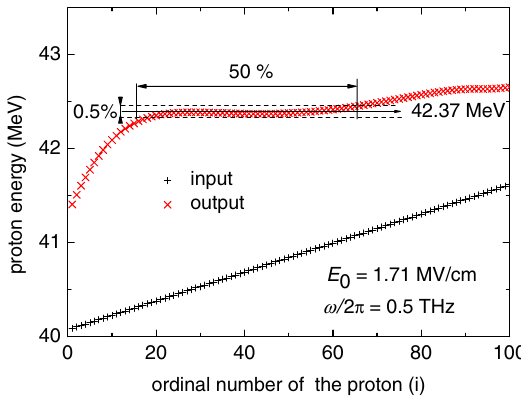
FIG. 5 . Input ( þ ) and output (×) energy distribution for a proton